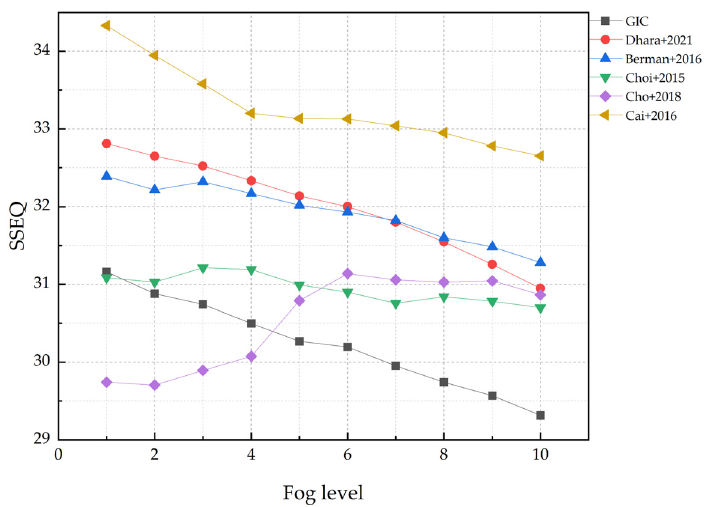
Figure 6. The SSEQ indicator changes of each method at multiple fog levels.